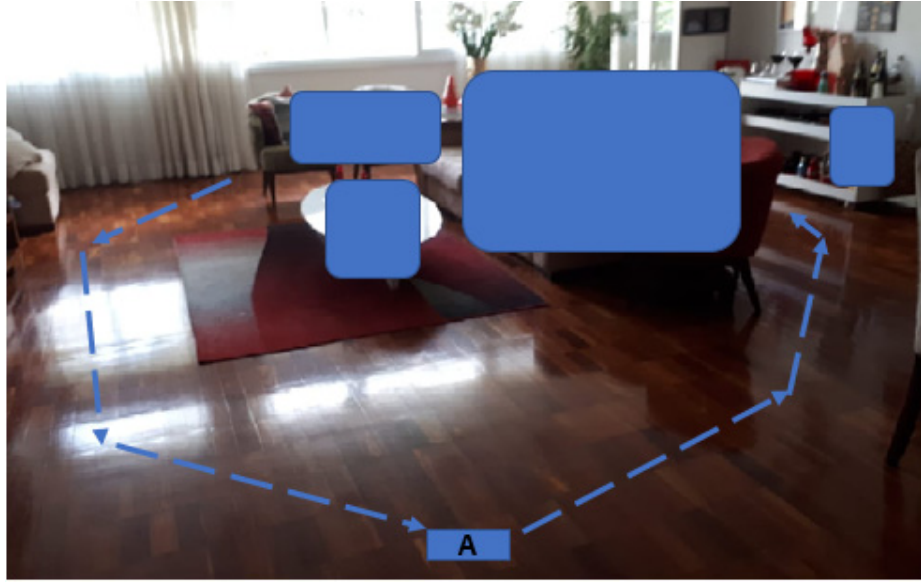
Figure 8. An example of a room, inside a house, that could be used to perform the free running. (A) represents the starting position for the